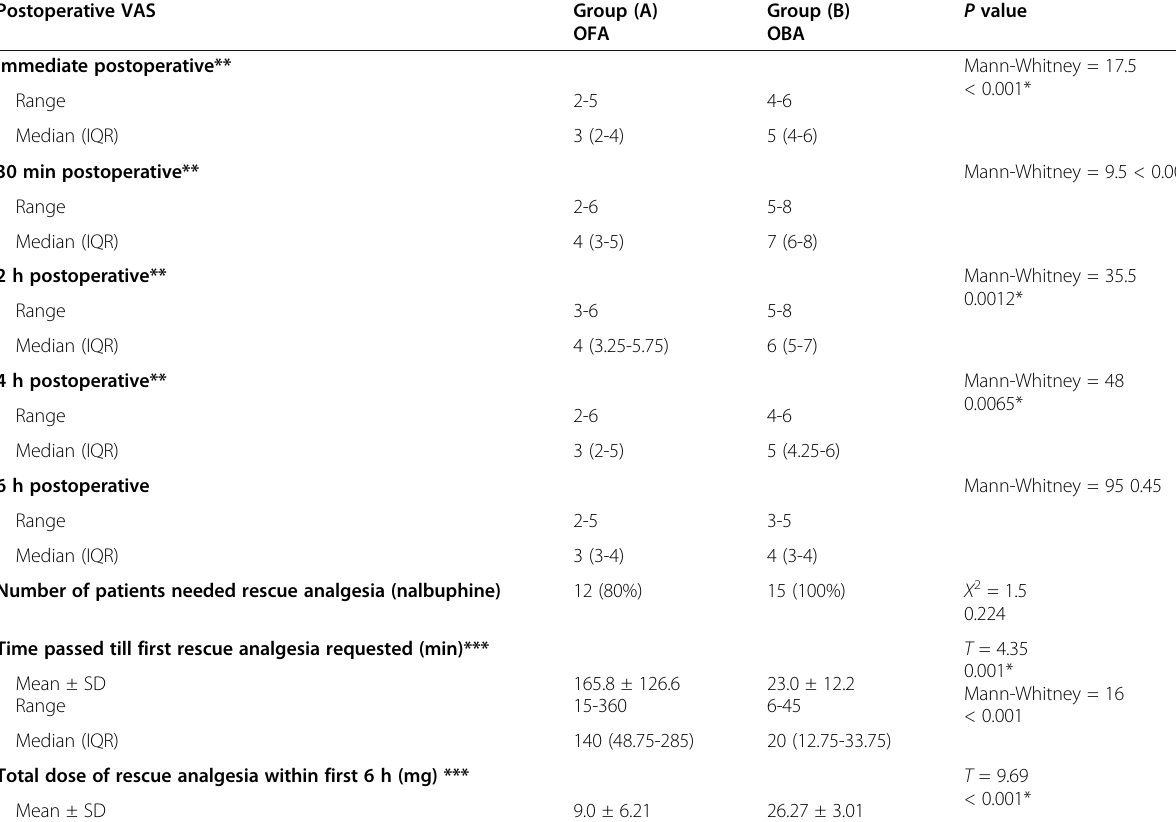
Table 2 The postoperative VAS and time needed till rescue analgesia requested and the total dose of rescue analgesia given Postoperative